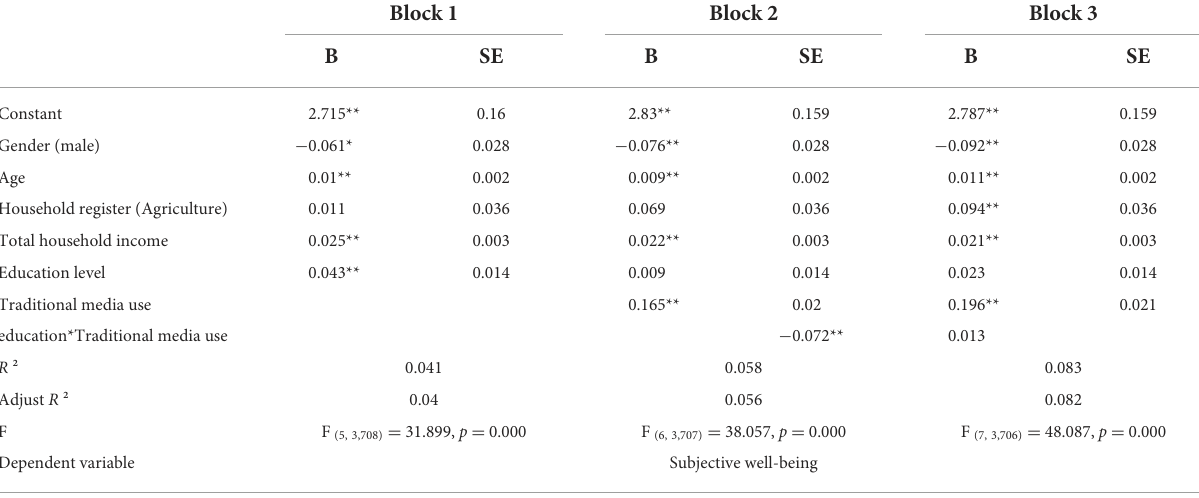
TABLE 10 Results of hierarchical regression analysis c.